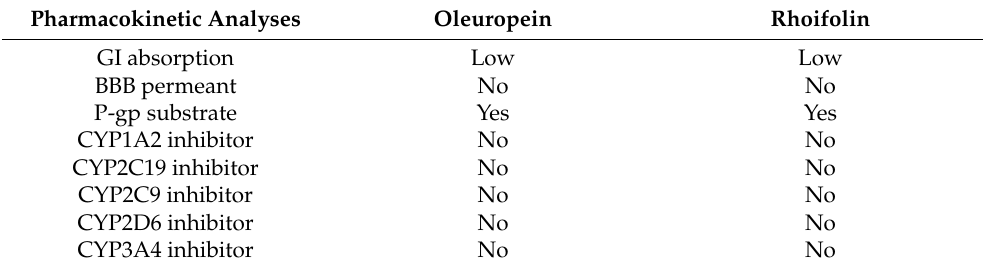
Table 4. Pharmacokinetic analyses of Oleuropein and Rhoifolin.